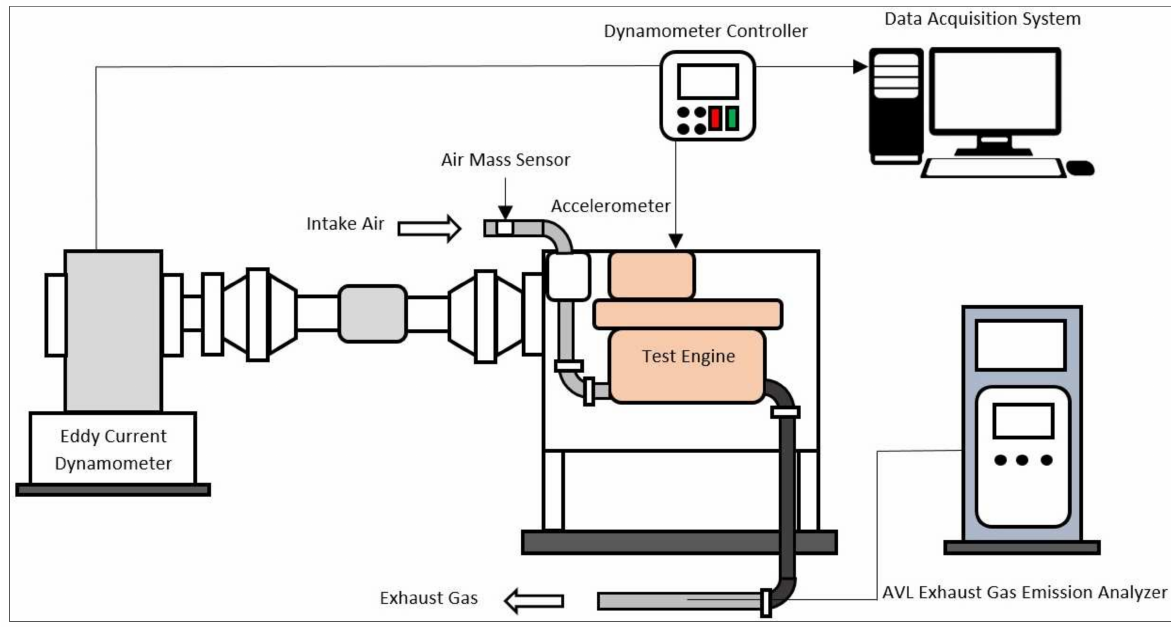
Figure 1. Schematic diagram of the diesel engine (Reprinted with permission from Elsevier, ref.